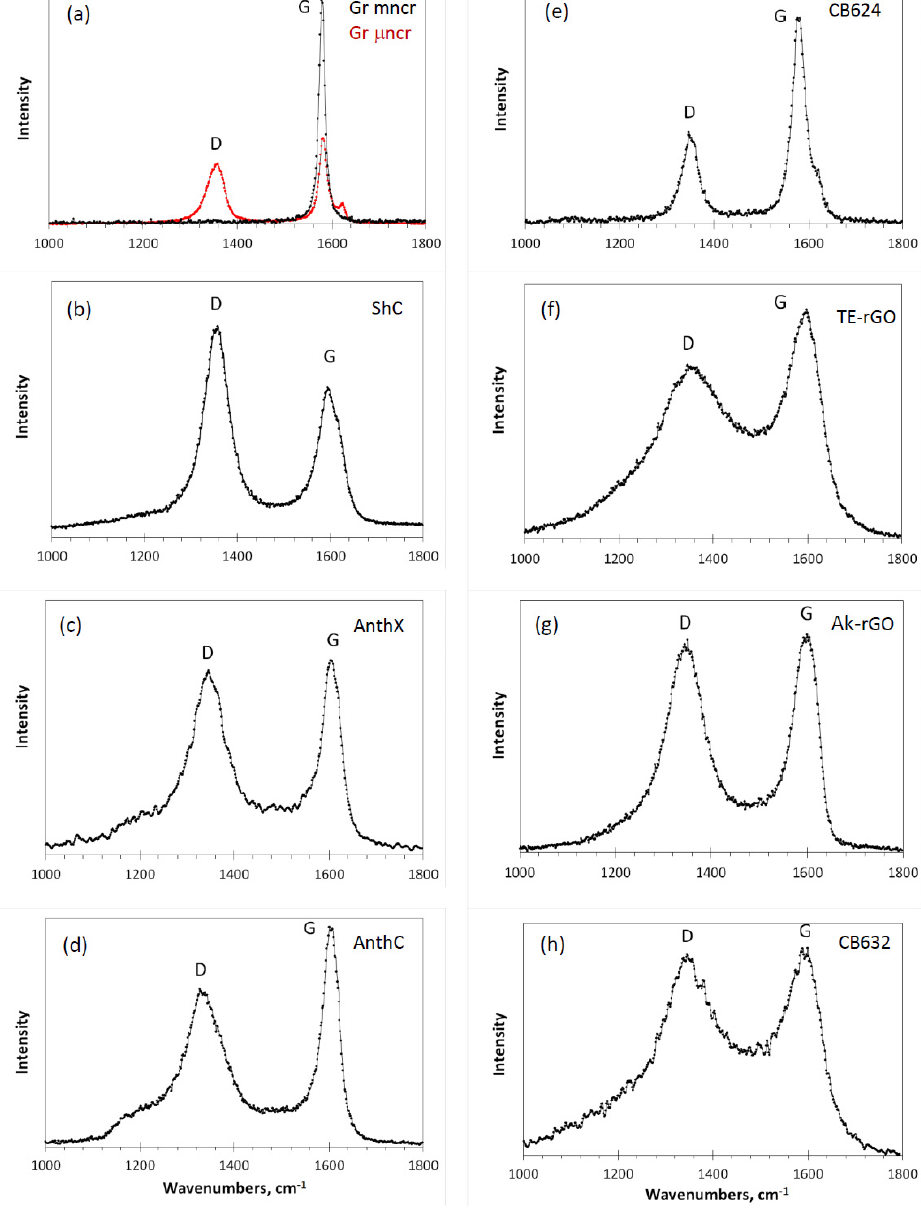
Figure 4. One-phonon Raman spectra of sp 2 amorphous carbons at room temperature: shungite carbon (ShC), anthraxolite (AnthX), anthracite (AnthC), technical graphene TE-rGO [27] and Ak-rGO [26], carbon blacks CB632 and CB624, as well as mono- (mncr) and micronanocstructured ( μ ncr) graphites, respectively; additional ( a – h ) marking facilitates the spectra description. Intensities are reported in arbitrary units.